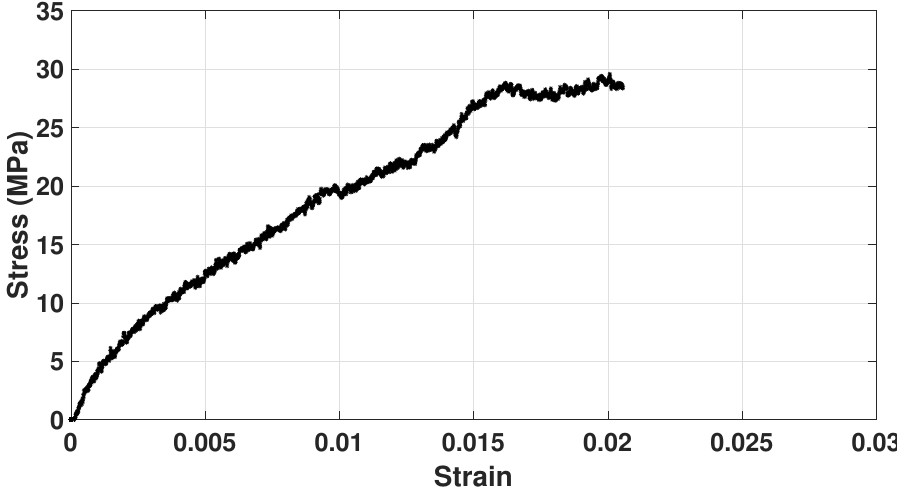
Figure 6. Sample of stress–strain curve extracted from the tensile tester for a single BNNT-PMMA fiber to extract the Young’s modulus of a single fiber ( E f